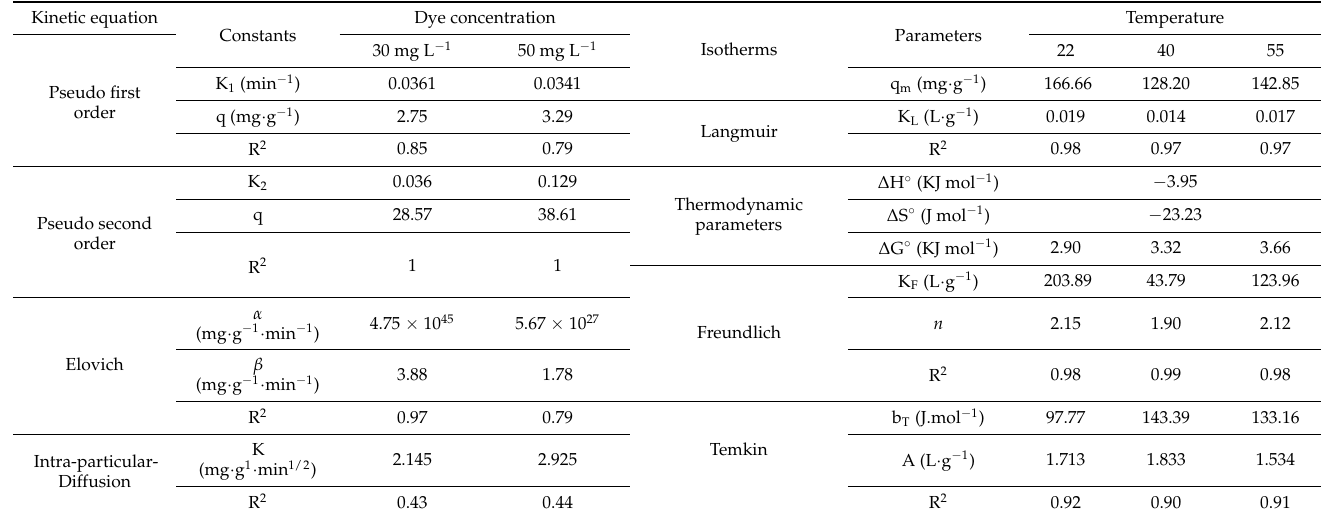
Table 2. Summarized kinetic data, Langmuir, Freundlich, and Temkin parameters for the adsorption of crystal violet on the surface of extracted cellulose from Populus tremula .